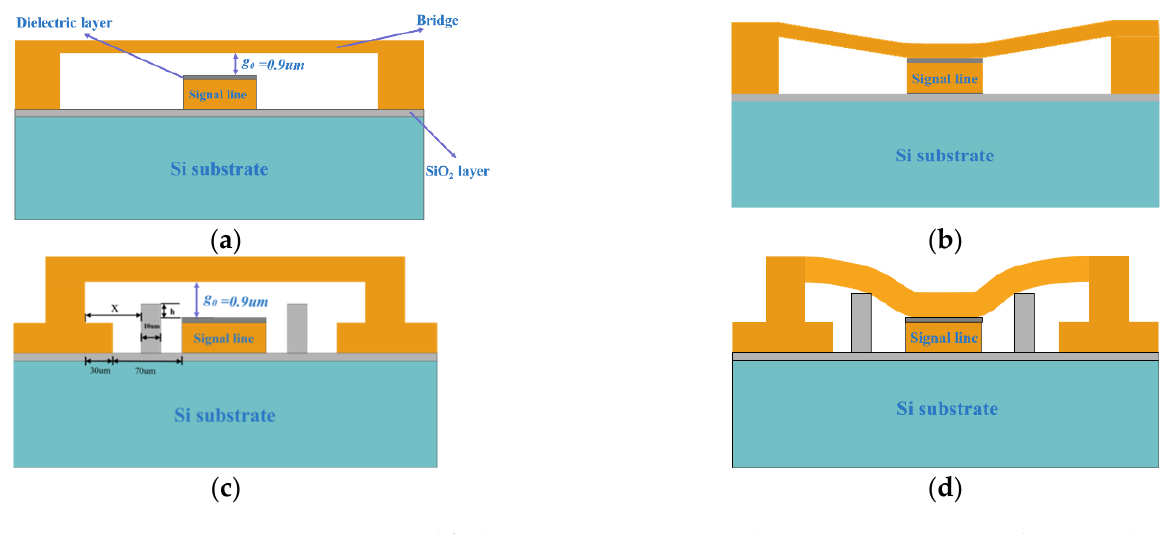
Figure 1. ( a ) Simplified capacitive RF MEMS switch OFF, ( b ) RF MEMS Switch ON, ( c ) The up state of the new RF MEMS switch, ( d ) The down state of the new RF MEMS switch .